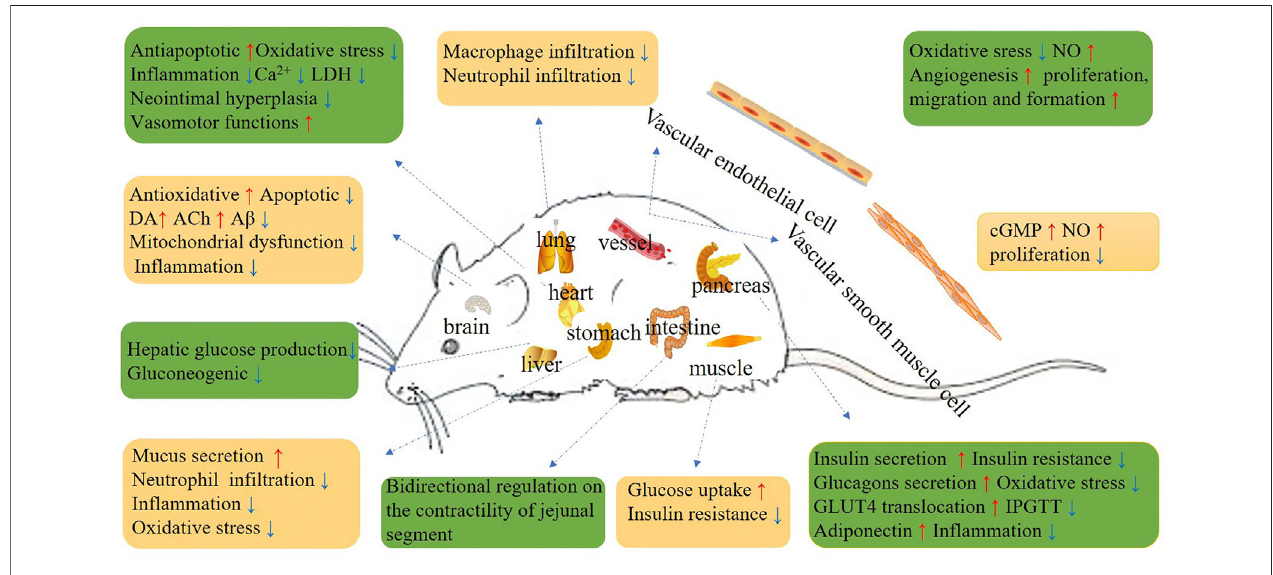
FIGURE 1 | Schematic diagram depicting the bene fi cial effects of